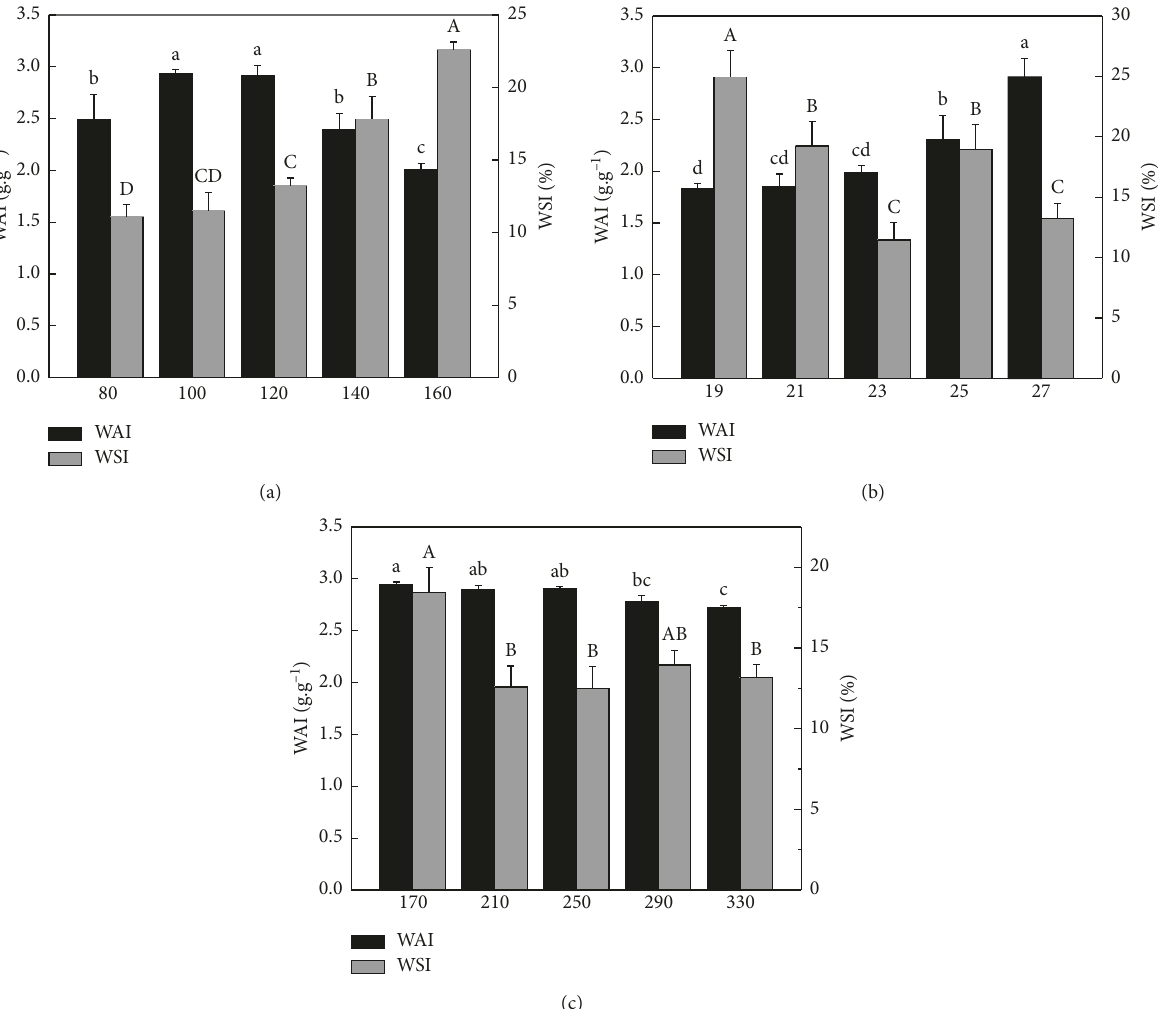
Figure 2: WAI and WSI of adlay flours treated by extrusion at different extrusion conditions. Uppercase and lowercase letters represent WSI and WAI, respectively. Different letters indicate significant differences ( p < 0 . 05). (a) Temperature ( ° C). (b) Moisture (%). (c) Screw speed